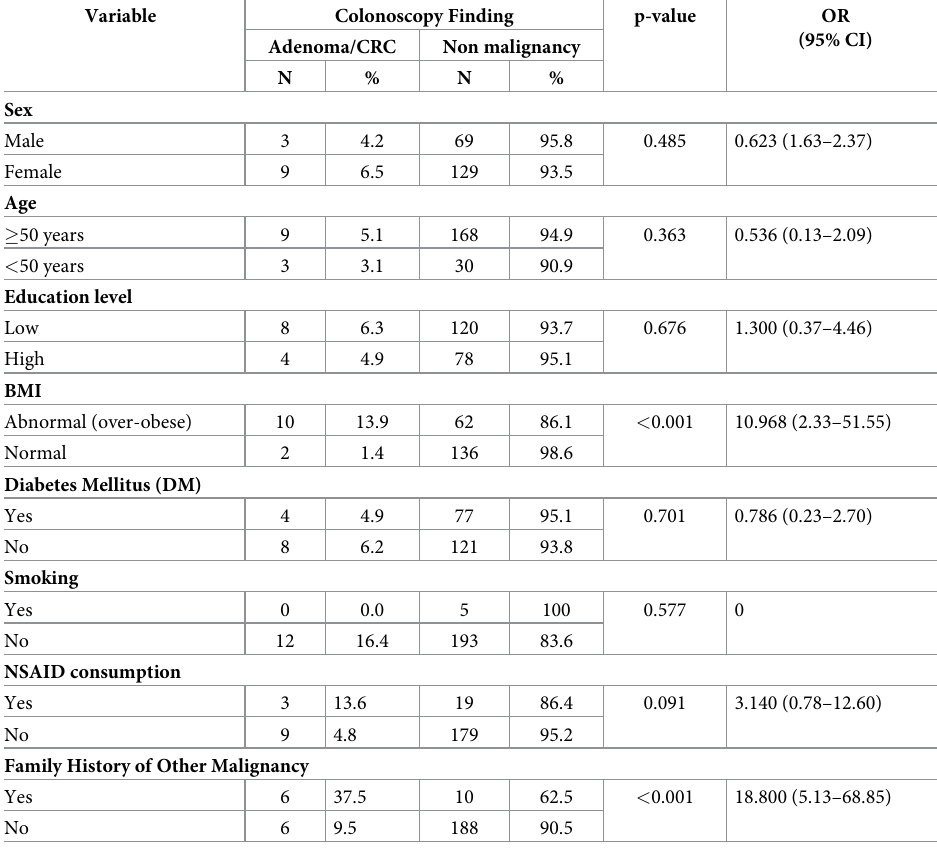
Table 5. Factors associated with pre-cancerous and cancerous